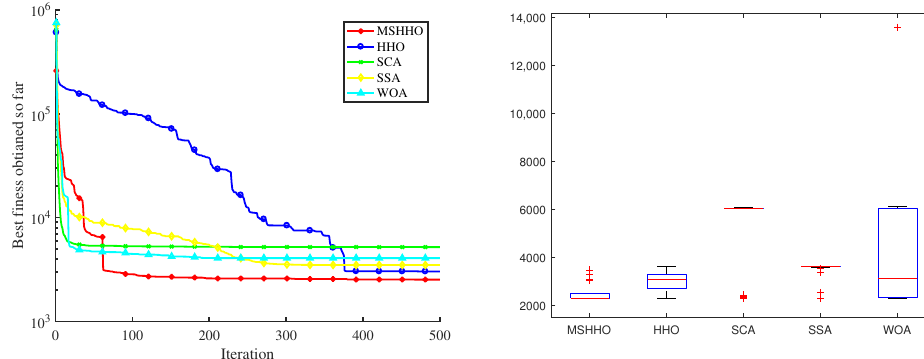
Figure 11. Qualitative results of pressure vessel design problem.